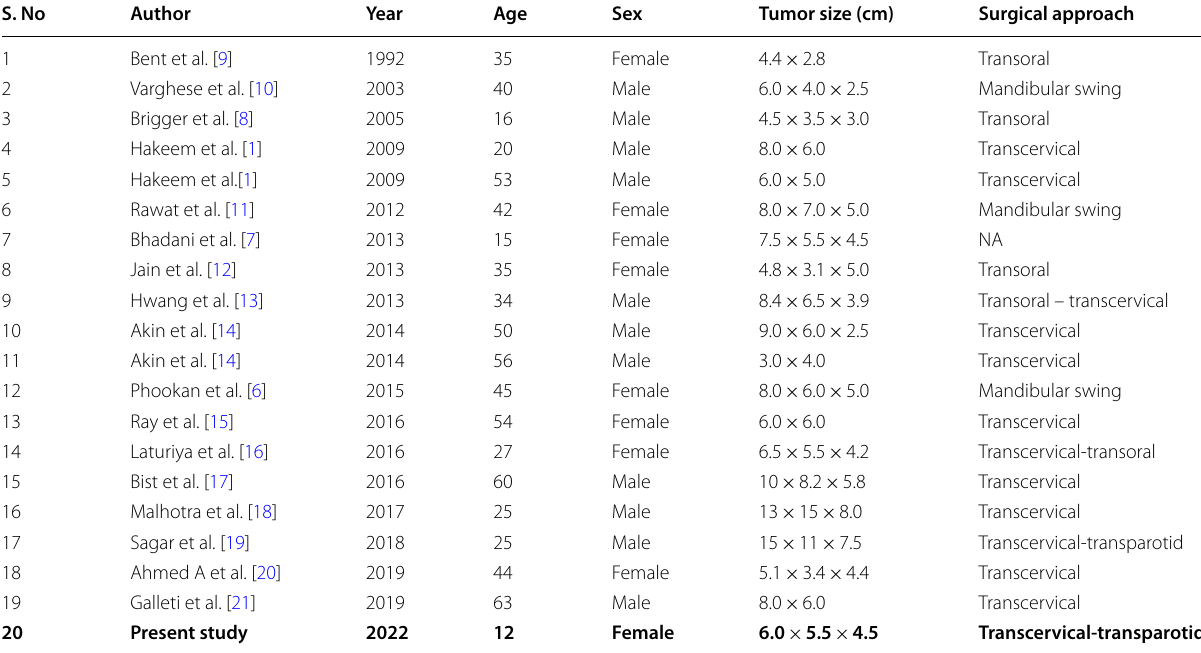
Table 1 Literature review, demography, tumor size, and surgical approaches of all reported de novo PPS pleomorphic adenoma (in chronological